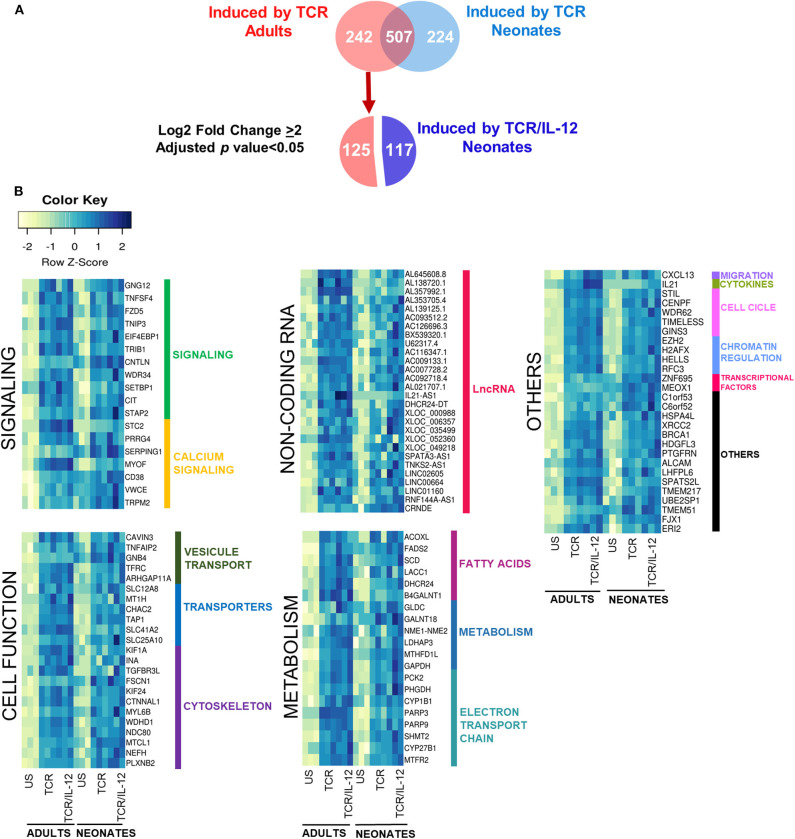
Genes induced by TCR signals in adult naïve CD8+ T cells, but only induced by TCR/IL-12 in the neonatal cells. (A) Venn Diagram showing the genes induced by TCR in adult cells that are only induced by TRC/IL12 in the neonatal cells, and (B) heatmaps of genes induced by TCR in adults CD8+ T cells, that only were induced by TCR/IL-12 in neonatal CD8+ T cells (adjusted p < 0.05 and log2 fold change ≥ 2), bars on the right display manual annotations of the functional categories.